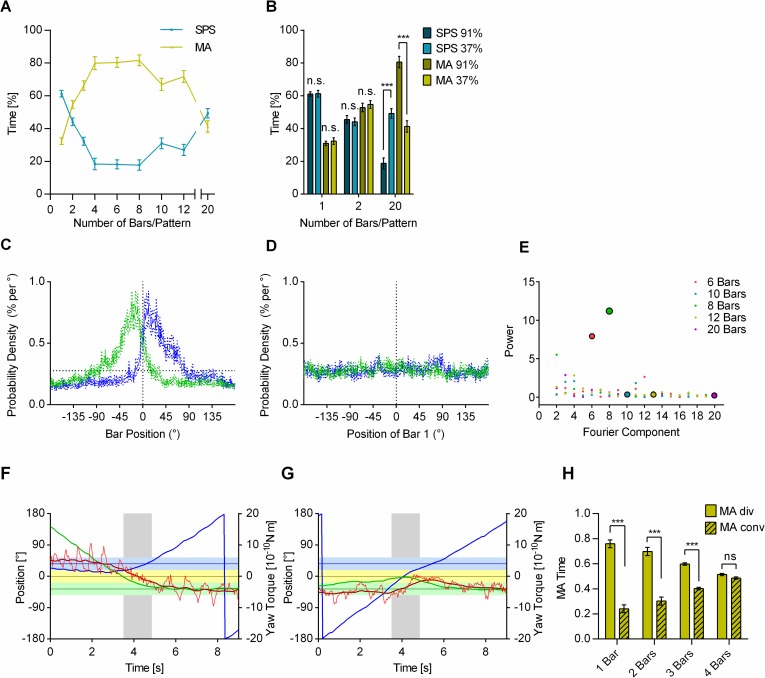
Object response may contribute to MA behavior.(A), With a low number of bars, SPS decreased when their number increased, and with many bars SPS went up again with increasing numbers. MA behavior developed inversely (mean ± SEM; n = 20 flies per number of bars). (B), Increased contrast had no effect on ratio of SPS and MA behavior with low number of bars, but with 20 bars the effect was highly significant (mean ± SEM; n = 20 flies per number of bars and contrast condition; data of the 37% contrast condition are the same as in (A); SPS 1 Bar: t(38) = 0.0686, p = 0.946, t test; MA 1 Bar: U = 188.5, p = 0.764, Mann-Whitney test; SPS 2 Bars: t(38) = 0.4210, p = 0.676, t test; MA 2 Bars: t(38) = 0.521, p = 0.606, t-test; SPS 20 Bars: U = 26, p < 0.0001, Mann-Whitney test; MA 20 Bars: U = 15, p < 0.0001, Mann-Whitney test). (C), With one vertical bar per pattern (width = 6°; contrast: 37%), the flies preferentially stabilized the bars in the frontal visual field on the side where their bias drove them progressively. Position histograms of the one bar per pattern experiment of (A). Green: bias ccw; blue: bias cw. Horizontal dotted line indicates chance level. (D), With 20 evenly spaced bars per pattern, no 18° modulation of the position histograms is apparent. Horizontal dotted line: chance value as in (C). (E), Power spectra of position histograms of orientation in closed loop with a single pattern of 6, 8, 10, 12, or 20 vertical bars (n = 20 flies per number of bars). Fourier transform showed fixation of bars for the 6- and 8-bar patterns but not for those with 10, 12, and 20 bars. The color code indicates the number of bars in the respective experiment. (F), A selected 9 s flight episode with one bar per pattern, in which the fly switched from fixating the cw bar to fixating the ccw bar after the bars cross each other. Grey area indicates the time during which average yaw torque (light red) was in the MA range. (Compare to Fig 2). (G), A selected 9 s flight episode in which the fly stabilized the ccw bar shortly interrupted this behavior in favor of MA behavior (grey area) after the bars cross, then returned to stabilizing the ccw bar. (H) Flies in the 1–3 bar/pattern experiment in (A) showed significantly more MA behavior with diverging bars. Bar chart of the fraction of time of MA behavior when the two bars div and conv (1 bar: t(19) = 5.082, p < 0.0001, ratio paired t test; 2 bars: t(19) = 5.177, p < 0.0001, ratio paired t test; 3 bars: t(19) = 10.14, p < 0.0001, ratio paired t test; 4 bars: W = −68, p = 0.2162; Wilcoxon matched-pairs signed rank tests). Underlying data can be found in S1 Data, https://doi.org/10.6084/m9.figshare.4668559.v1 and https://doi.org/10.6084/m9.figshare.4668565.v1. ccw, counterclockwise; cw, clockwise; conv, converging; div, diverging; MA, motion average; SPS, single pattern stabilization.